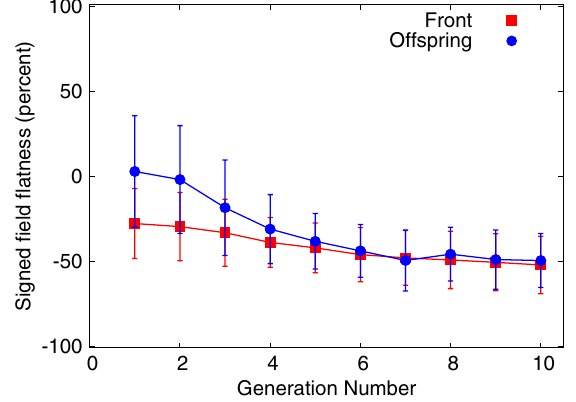
FIG. 25. Average signed field flatness for the Pareto-optimal front and offspring for each